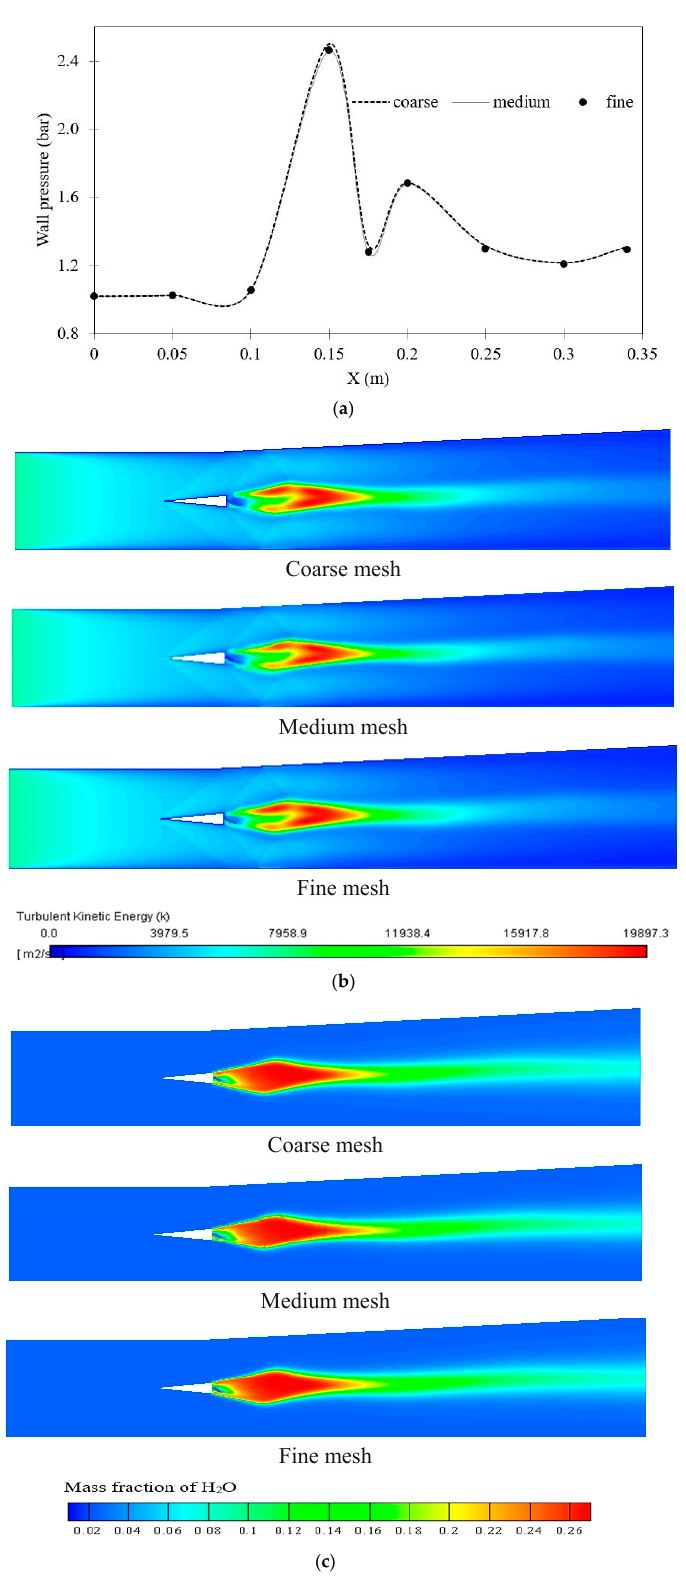
Figure 2. ( a ). Grid independence study: static pressure distribution along the bottom wall of the combustor. ( b ) Grid independence study: turbulent kinetic energy. ( c ) Grid independence study: mass fraction of H 2 O.